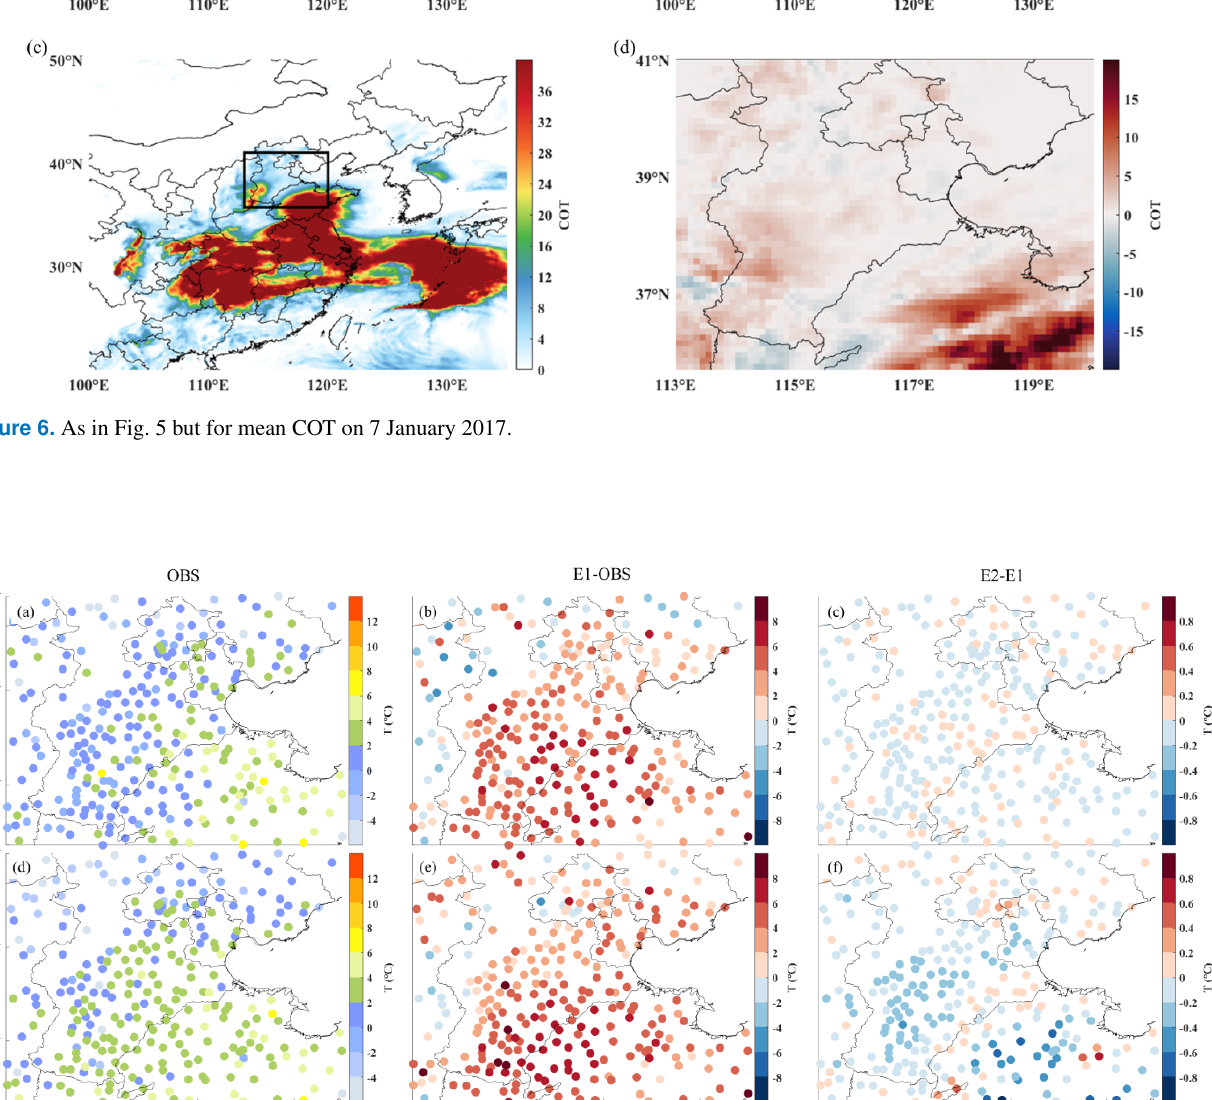
https://doi.org/10.5194/acp-22-15207-2022 Atmos. Chem. Phys., 22, 15207–15221,